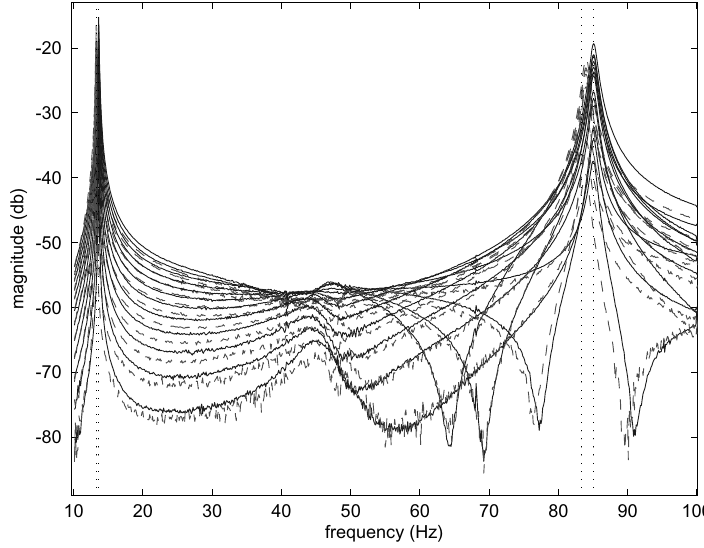
Fig. 27. Response functions for undamaged (full line) and damaged case (dashed line) with excitation in DOF 1 for both